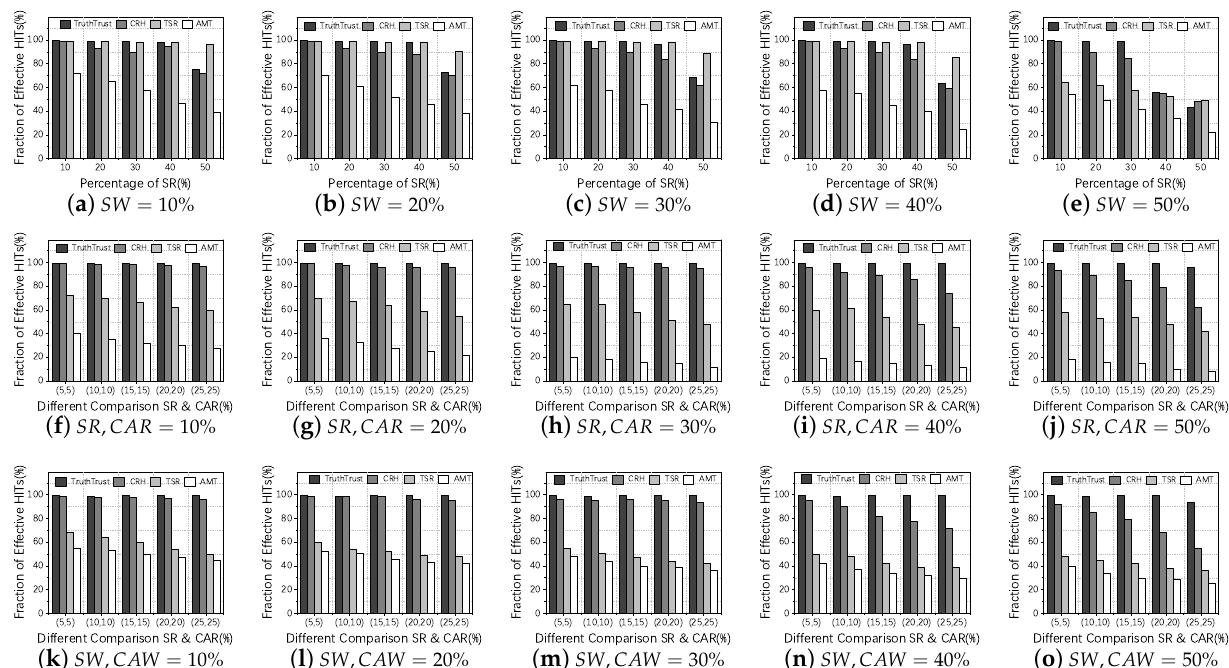
Figure 8. ( a – e ) show the effectiveness of different models under Threat Pattern A; ( f – j ) show the effectiveness of different Figure 8. Subfigure ( a – e ) shows the effectiveness of different models under Threat Pattern A. Subfigure ( f – j ) shows the effectiveness models under Threat Pattern B; ( k – o ) show the effectiveness of different models under Threat Pattern of different models under Threat Pattern B. Subfigure ( k – o ) shows the effectiveness of different models under Threat Pattern C. of requesters and workers tends to 99.2% when malicious participants are less than 50%.